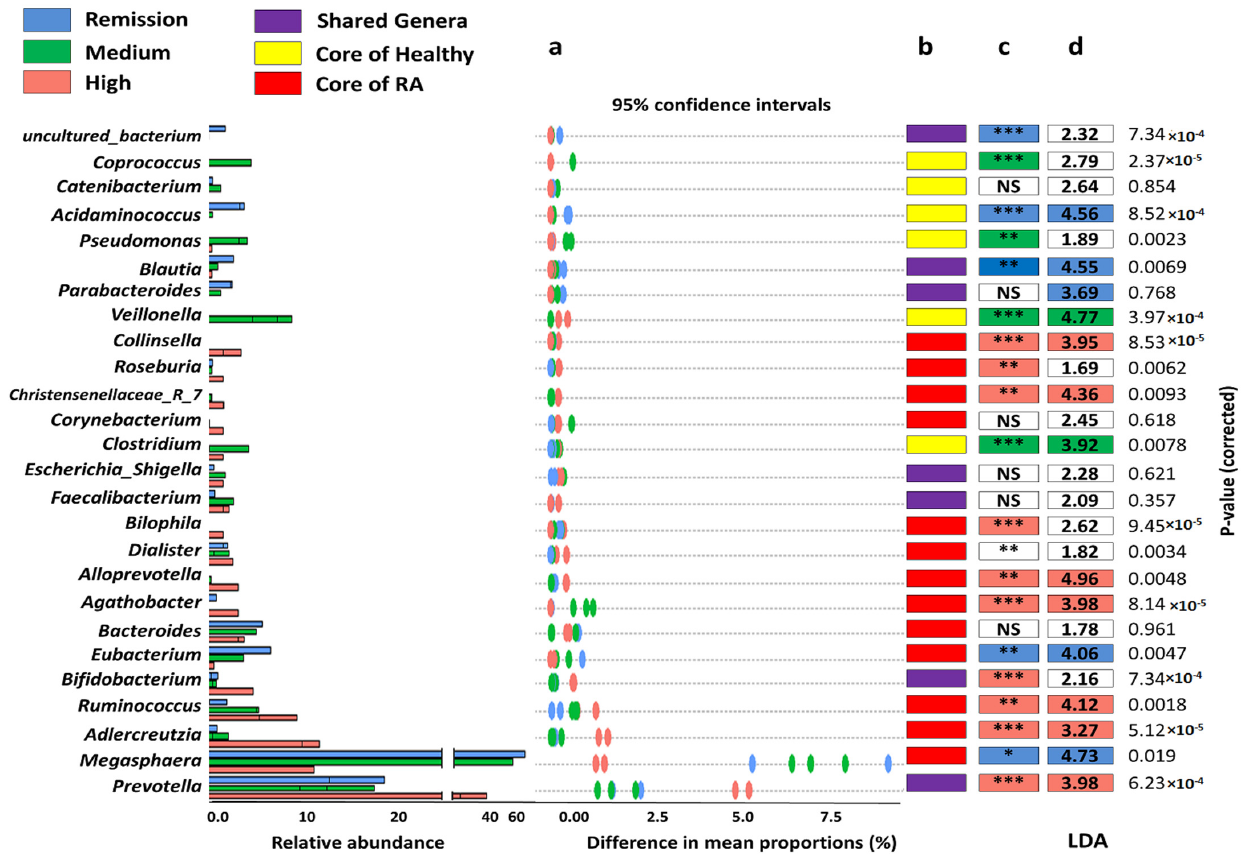
Figure 3. The genus level analysis of gut microbiomes in healthy and RA participants. ( a ) Bar plots define the mean proportion and differences in mean proportions with 95% confidence intervals. ( b )